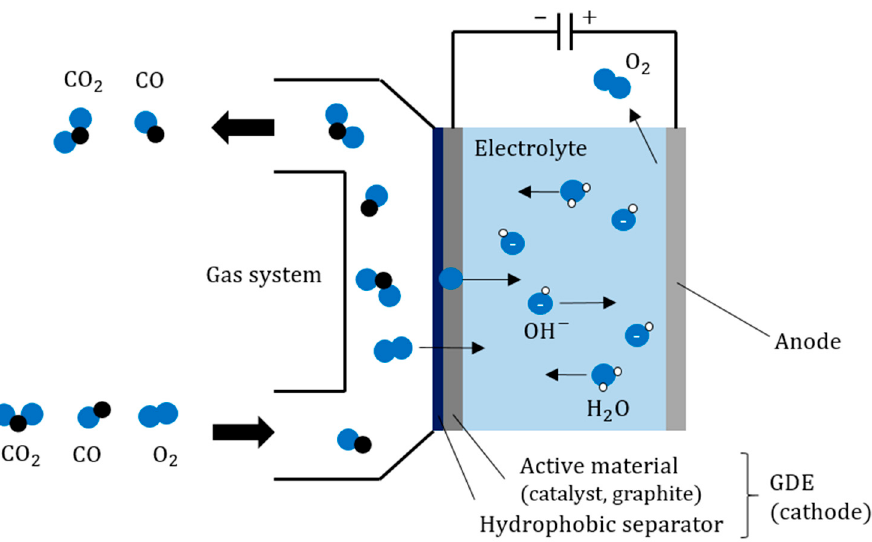
Figure 4. Scheme of the working principle of a gas diffusion electrode as an oxygen removal de- vice.